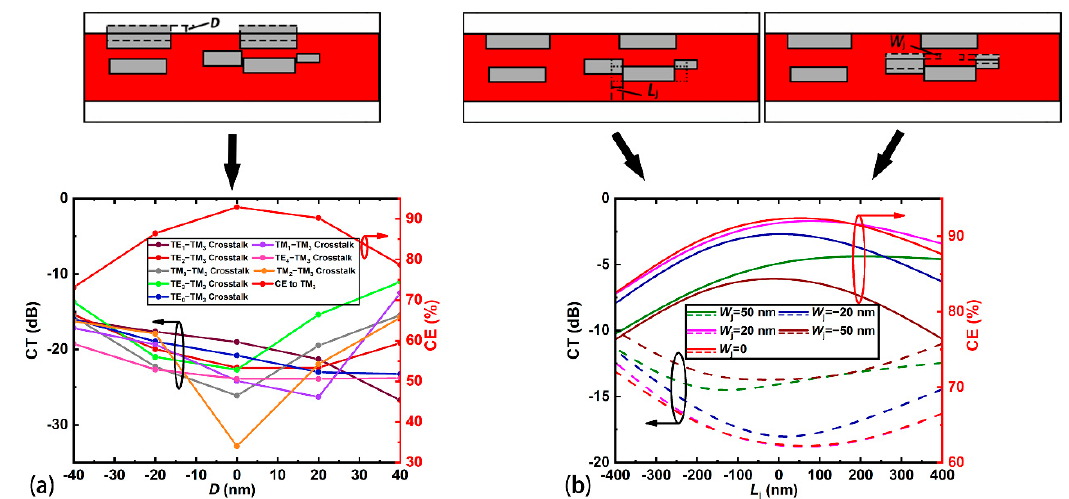
Figure 6. Device performance dependent on ( a ) the relative position shift D between the shallowly etched pattern and the silicon waveguide, ( b ) the length variation of slot 5 ( L j ) and width variation of slot 3 and slot 6 ( W j ) where the total lengths of slots 3, 5, and 6 are kept unchanged.